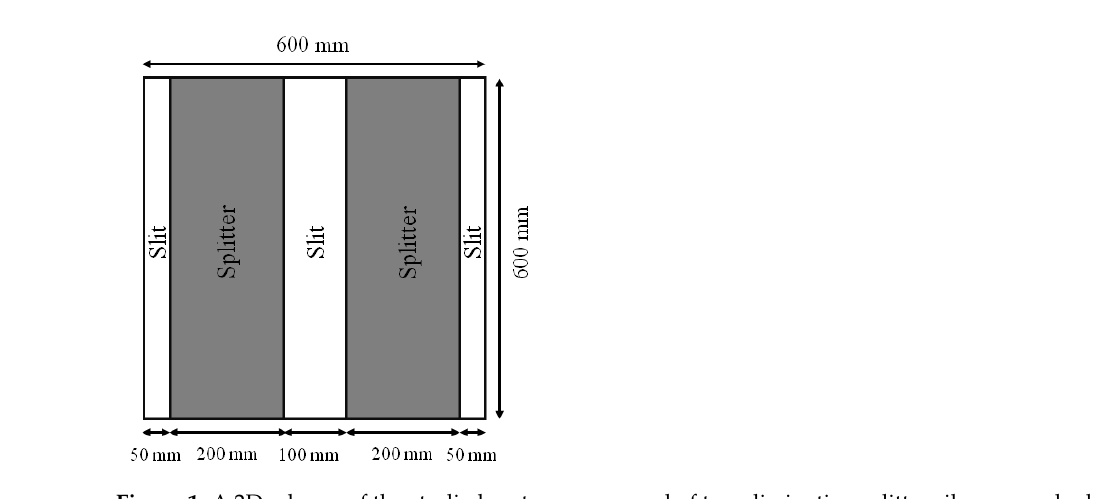
Figure 1. A 2D scheme of the studied system, composed of two dissipative splitter silencers embed- ded in a duct.